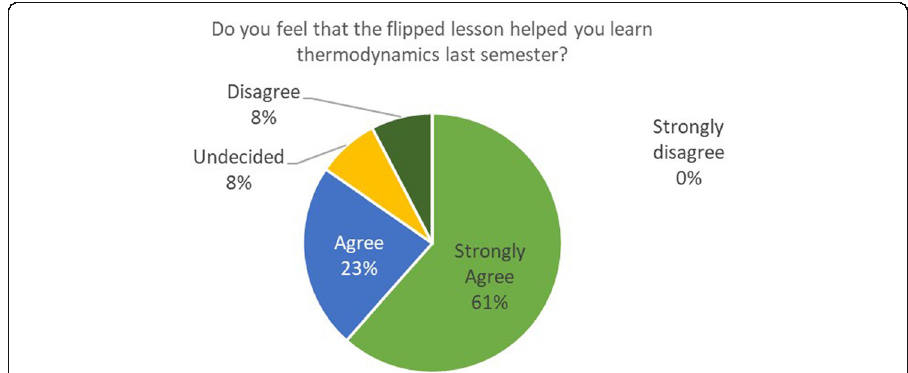
Fig. 1 January 2016/2017 students ’ feedback on the flipped